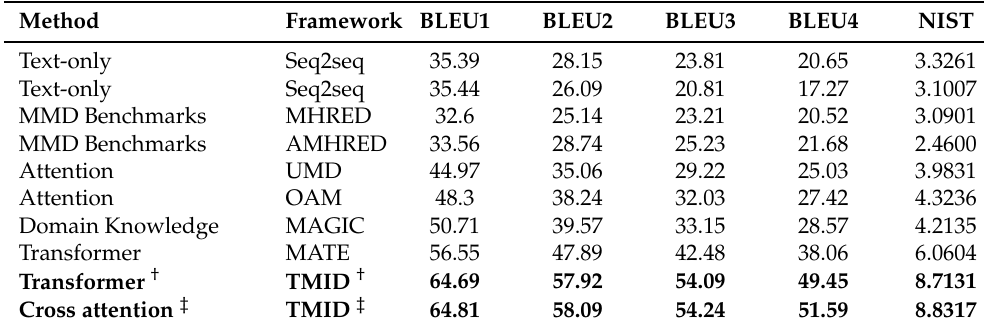
Table 1. Performance comparison between TMID and baseline models on textual response generation.